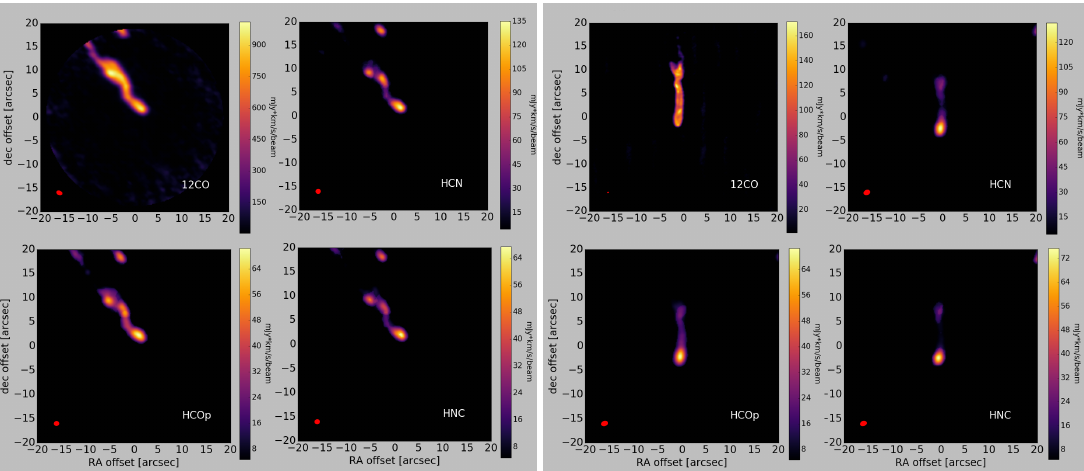
Figure 2. ( Left ) ALMA moment 0 image stamps of Globule B in 1 mm and 3 mm transitions of 12 CO, HCN, HCO + , and HNC. ( Right ) ALMA moment 0 image stamps of Globule C in the same molecular transitions as Globule B. CO image also published in [18].